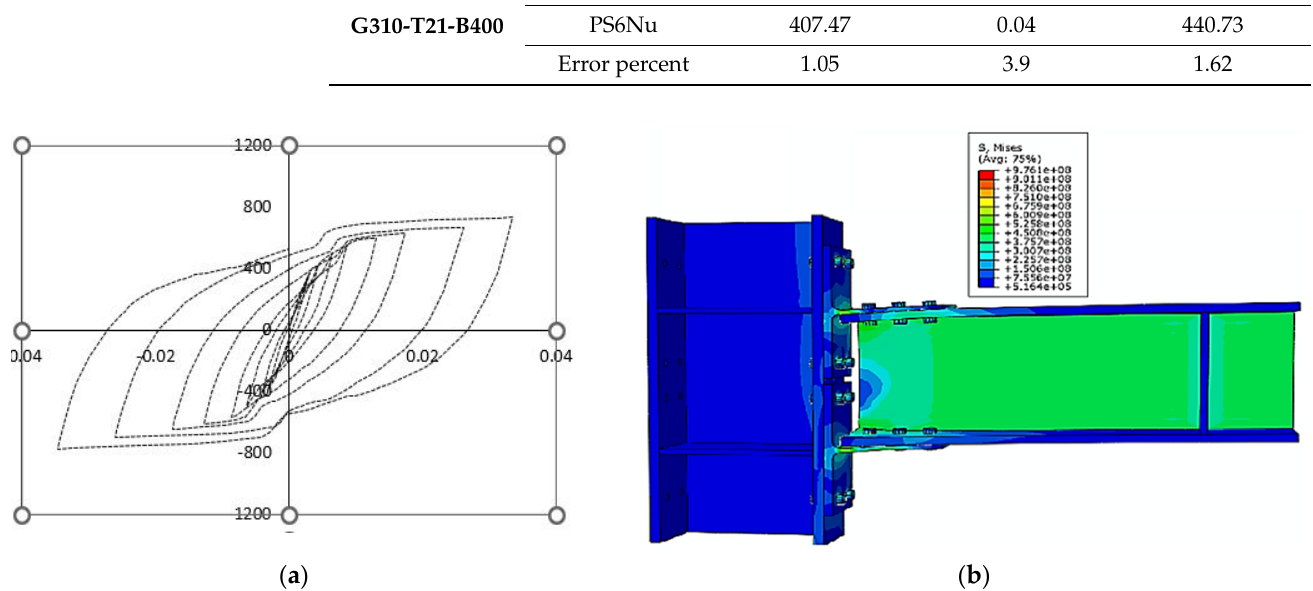
Figure 4. ( a ) Hysteresis curve and ( b ) Von Mises stress distribution for G310-T19-B400 model. The G310-T19-B400 model was considered the verification model (SP02) for further investigation. The parametric specifications for the developed models are presented in Table 3, where tf, Fyt, and Fyb are the T-stub’s thickness, the T-stub’s yield stress, and the bolt’s yield stress, respectively. L1 and L2 are the arrangement of bolt holes on the T-stub web, as depicted in Figure 5. All dimensions are in